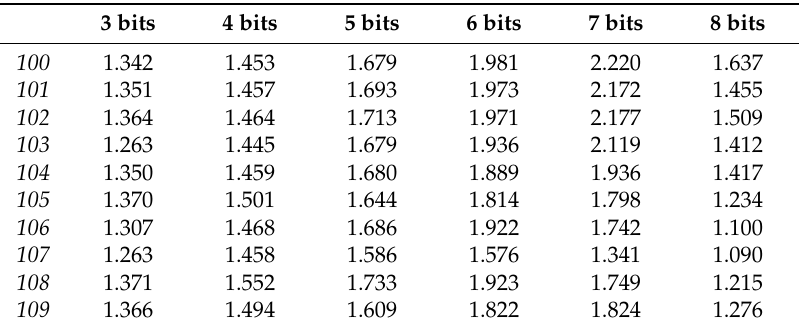
Table 1. Compression rate for high-bit resolution.